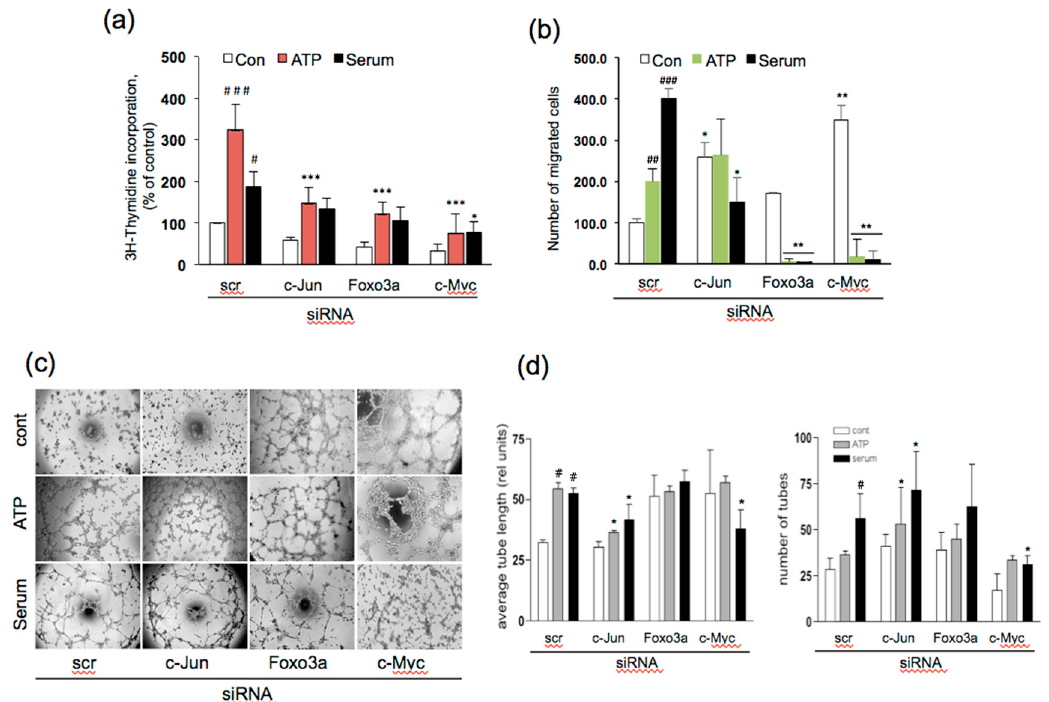
Figure 5. Effect of siRNA-mediated knockdown of c-Jun, Foxo3a, and c-Myc on ATP-stimulated proliferation, migration, and tube formation of VVECs. Cells were transfected with scramble siRNA or siRNA to c-Jun, Foxo3 and c-Myc using Dharmafect Reagent® following the protocol